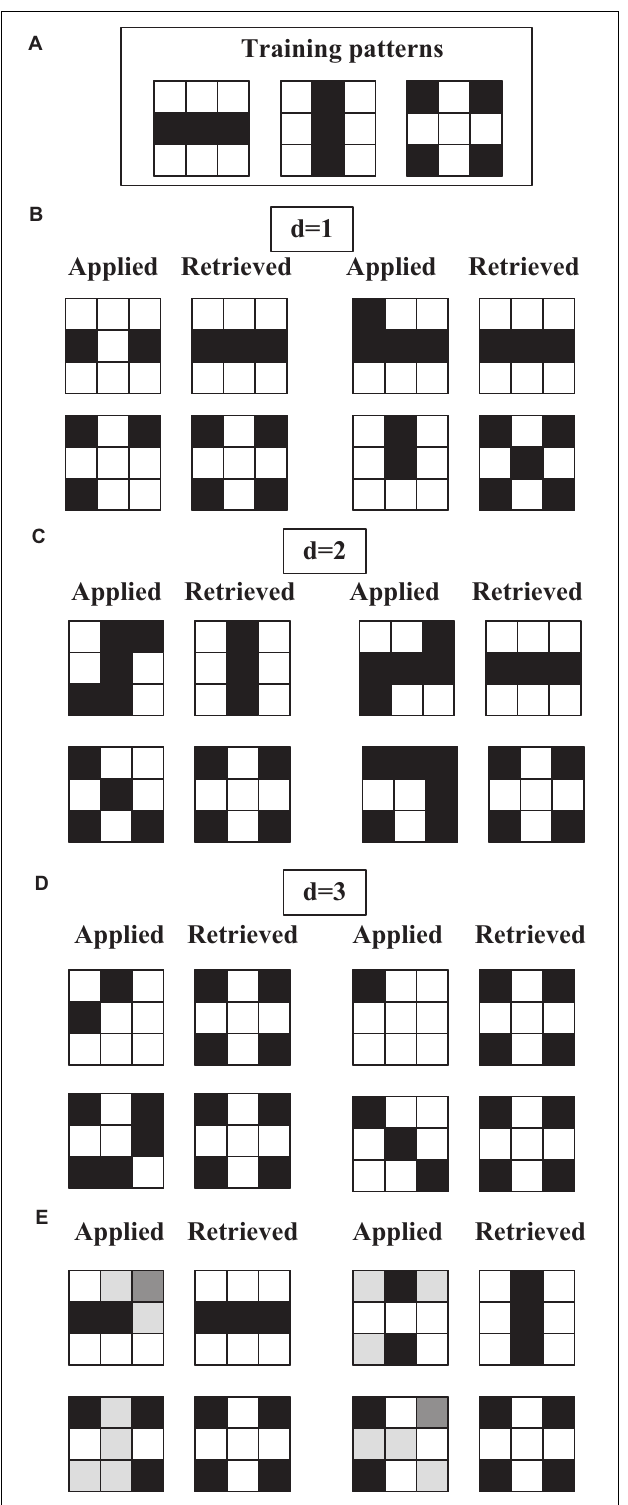
FIGURE 7 | 3 × 3 ONN experiment. (A) Training patterns. (B–D) Applied and retrieved patterns for Hamming distances of 1, 2, and 3, respectively, from the training patterns. (E) Applied and retrieved patterns for test patterns generated from the training ones adding gray pixels with different intensities.